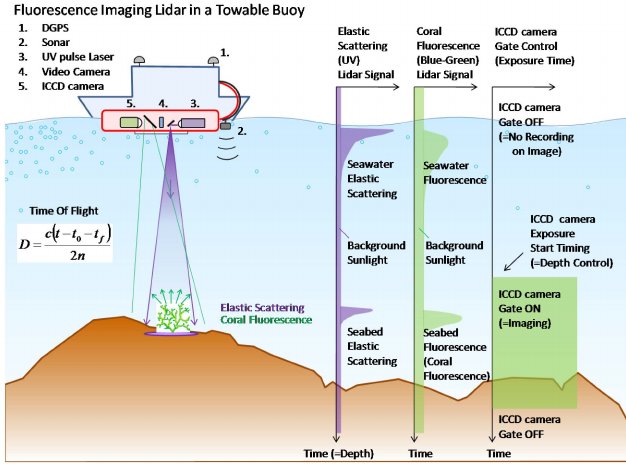
Figure 3. Schematic of the fluorescence imaging LIDAR system.